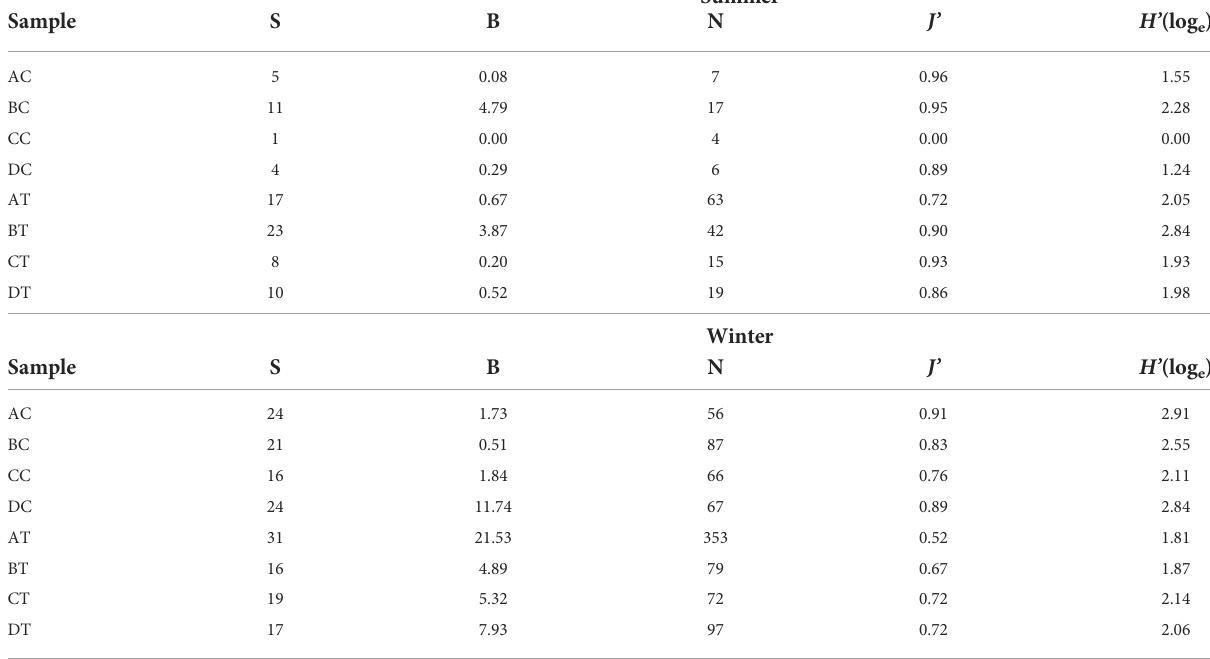
TABLE 2 Univariate analysis of pooled abundance data (0.5 m 2 ) for summer and winter sampling.